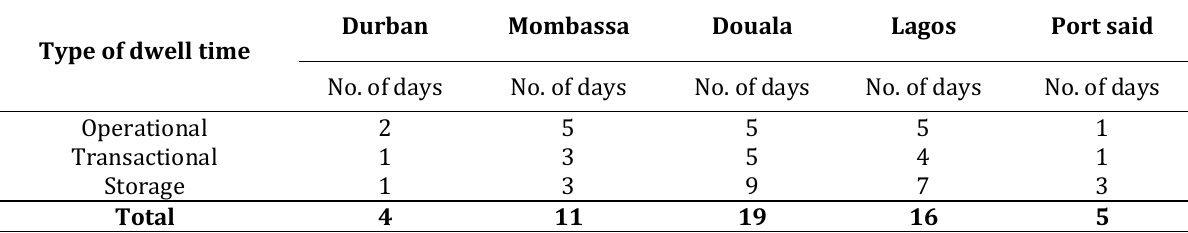
Table 4.1: Comparison of Cargo Dwell Time in Major African Ports Type of dwell time